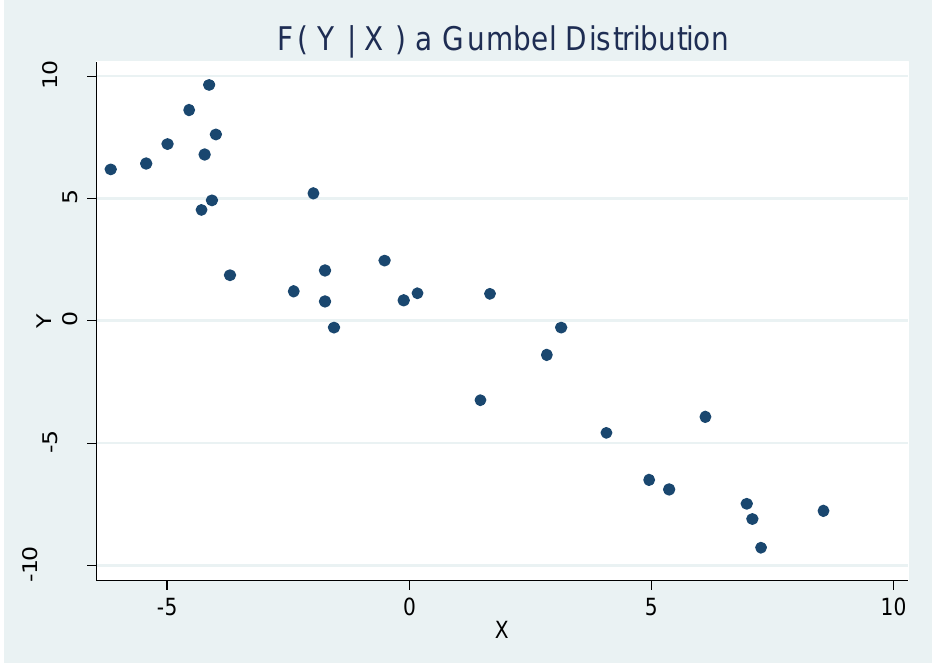
Figure 1. A typical conditional Gumbel distribution with sparse observations for each conditional value of observed X